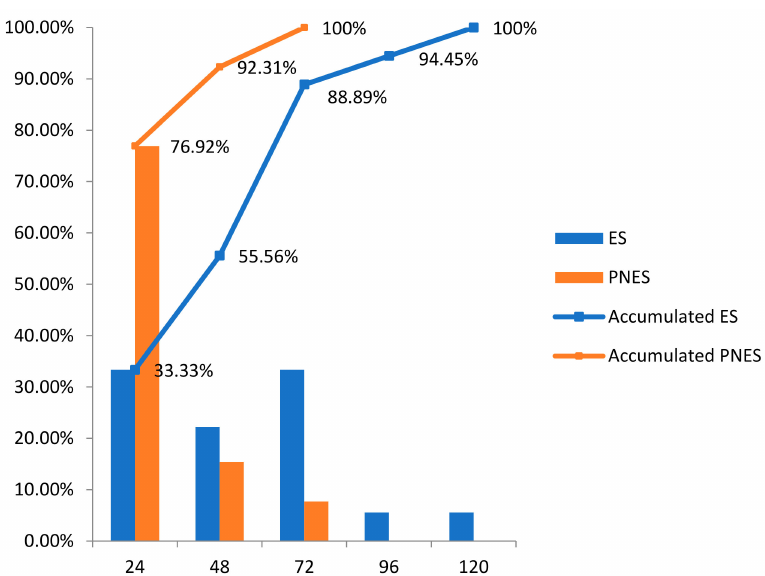
Figure 7. Distribution of the first